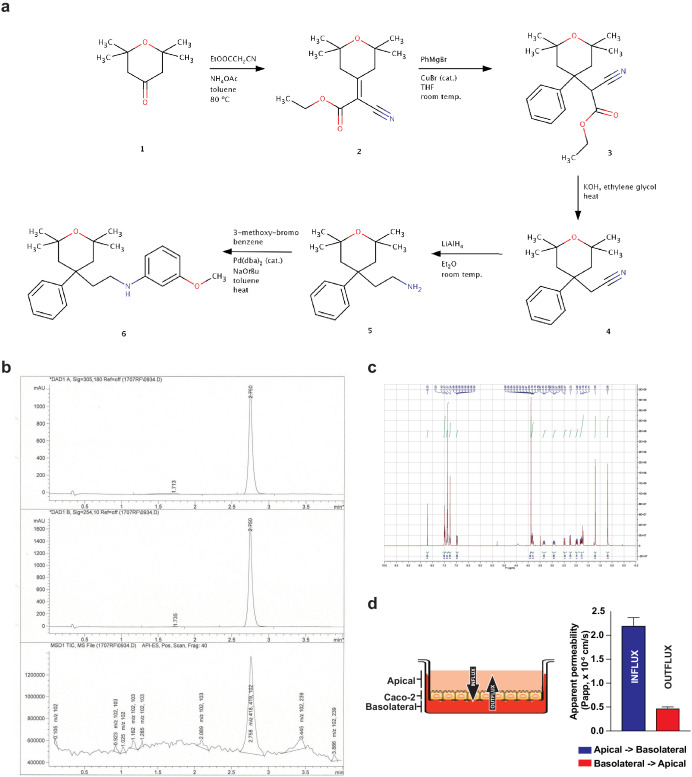
C75 synthesis and absorption, distribution, metabolism, and excretion (ADME) test.(a) Schematic of the C75 synthesis reactions. (b) Mass spectra of the final product. (c) Nuclear magnetic resonance spectra of C75. (d) Left, schematic of the apparent permeability assay through a layer of Caco-2 cells. Right, quantification of apical-to-basolateral (blue) and basolateral-to-apical (red) absorption rates across a Caco-2 cell layer.